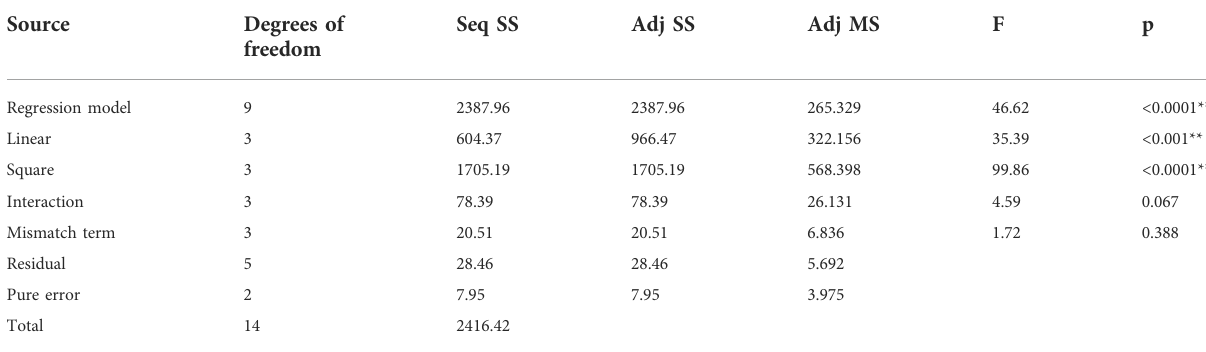
TABLE 9 Analysis of variance of regression model.